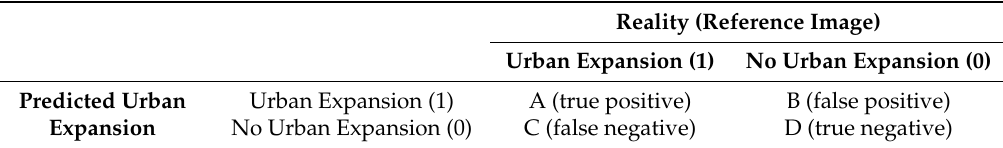
Table 7. Two by two contingency (the number of grid cells in actual map versus a predicted